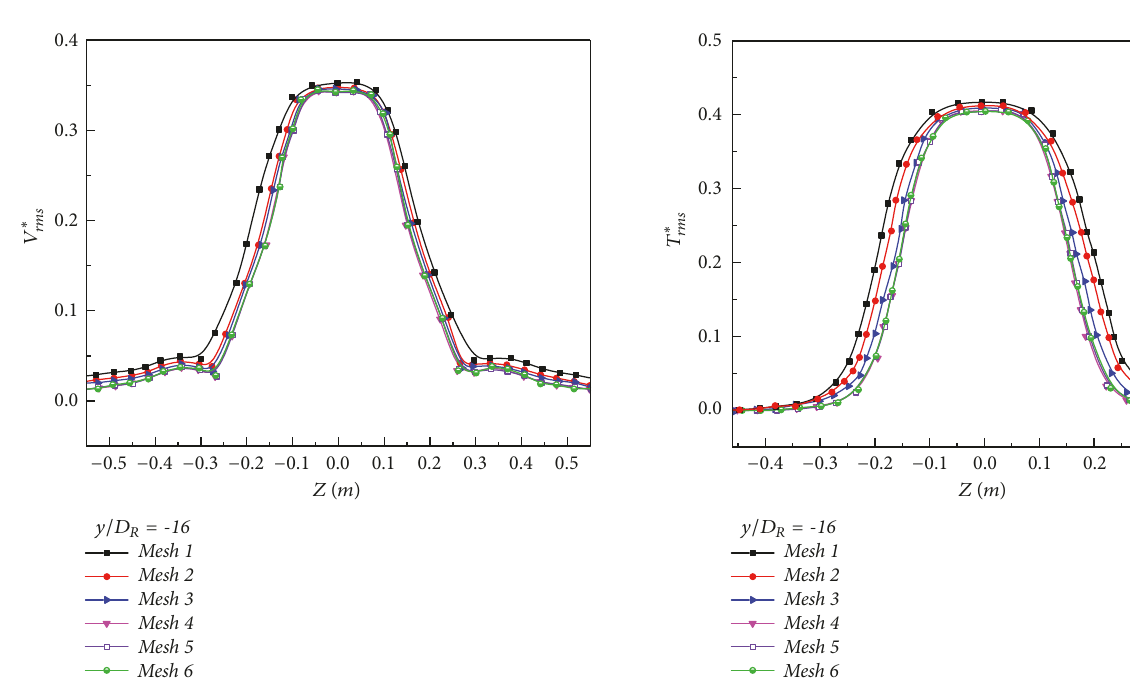
Figure 12: The dimensionless RMS velocity distribution of mesh sensitivity study.